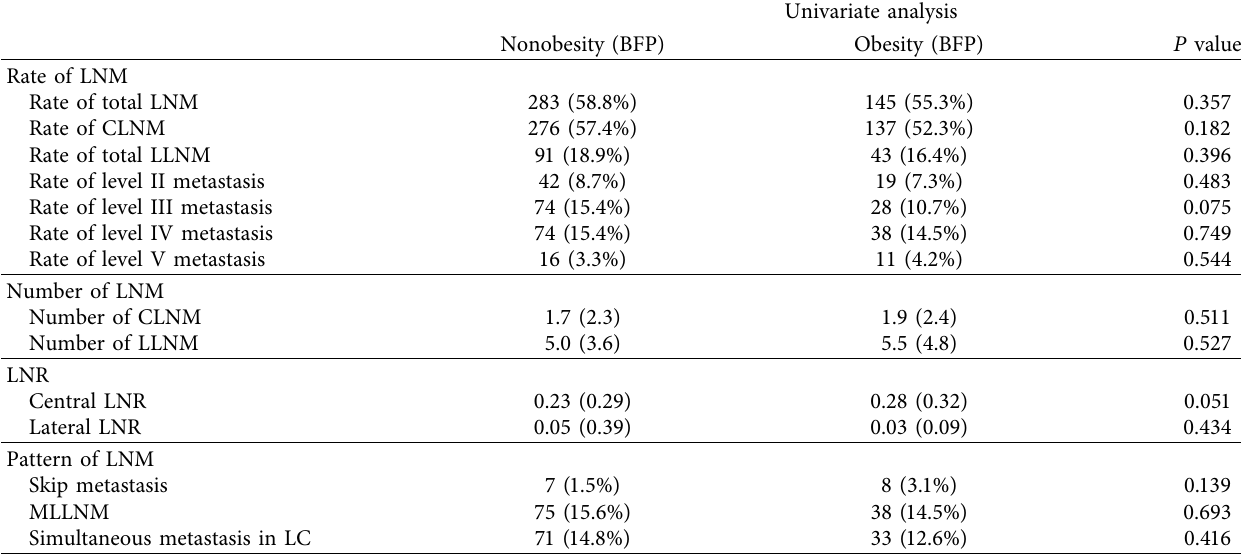
Table 4: Relationship between BFP and diferent regional lymph node involvement in women.